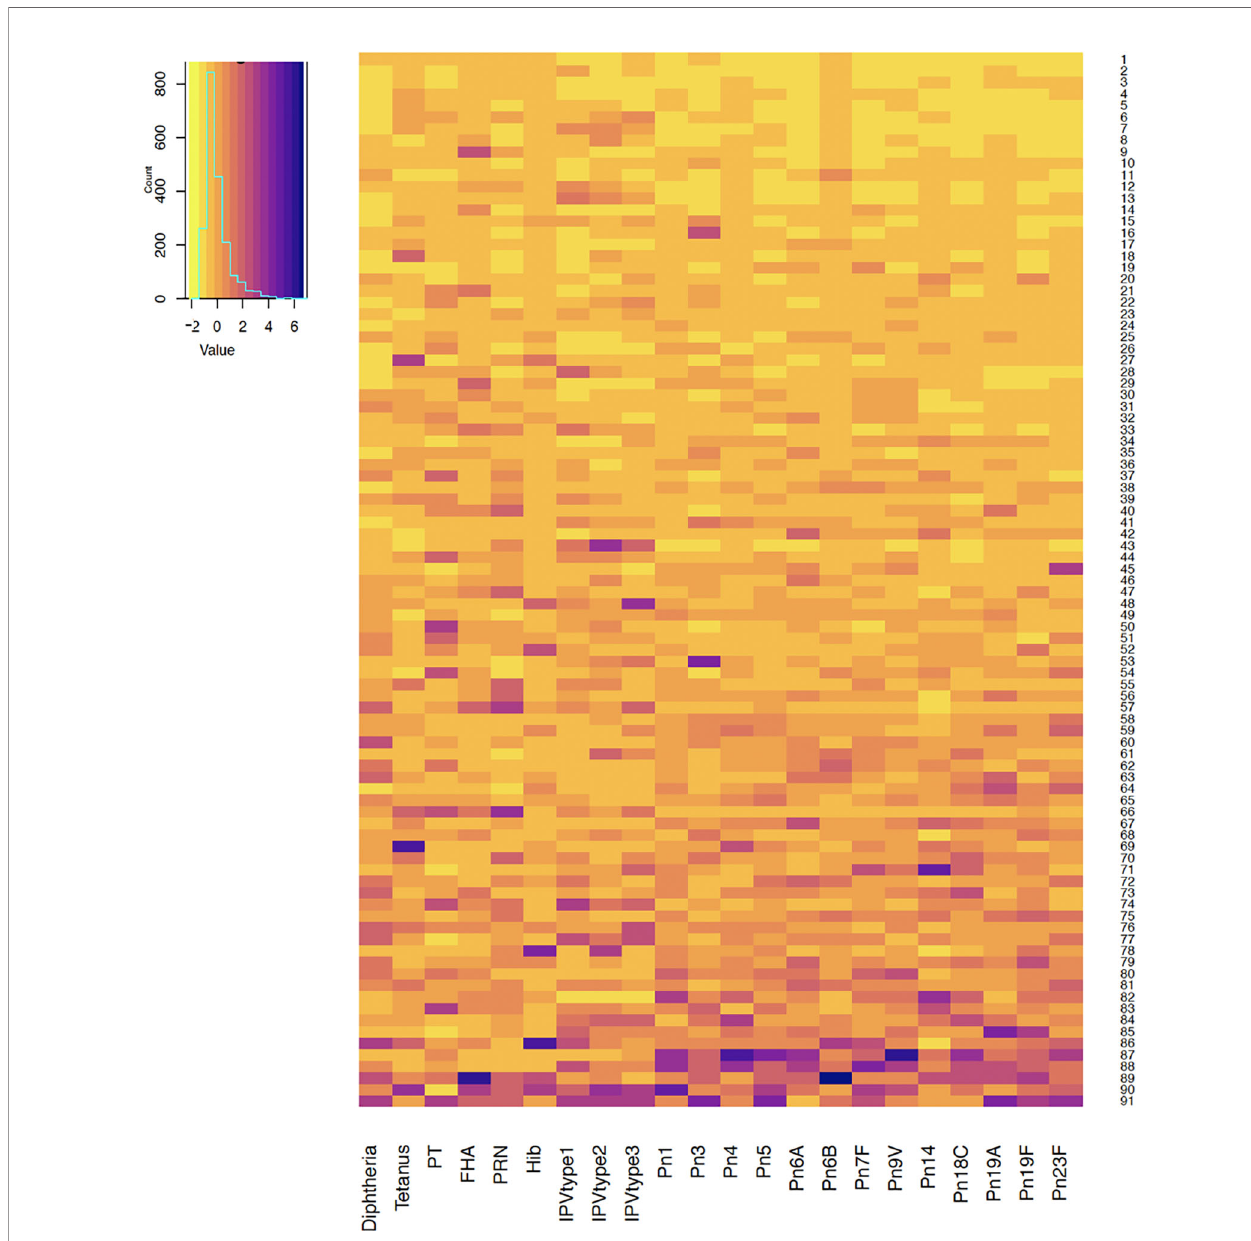
FIGURE 1 | Antibody responses to vaccine antigens measured one month after the 6-month vaccinations (at 7 months of age) in 91 participants. Each row depicts one participant with the colour in each column representing the ‘ scaled ’ vaccine antibody response [(individual vaccine response - mean vaccine response)/standard deviation] in that individual. PT, pertussis toxin; FHA, fi lamentous haemagglutinin; PRN, pertactin; Hib, Haemophilus in fl uenzae type b; IPV, polio; Pn, pneumococcal